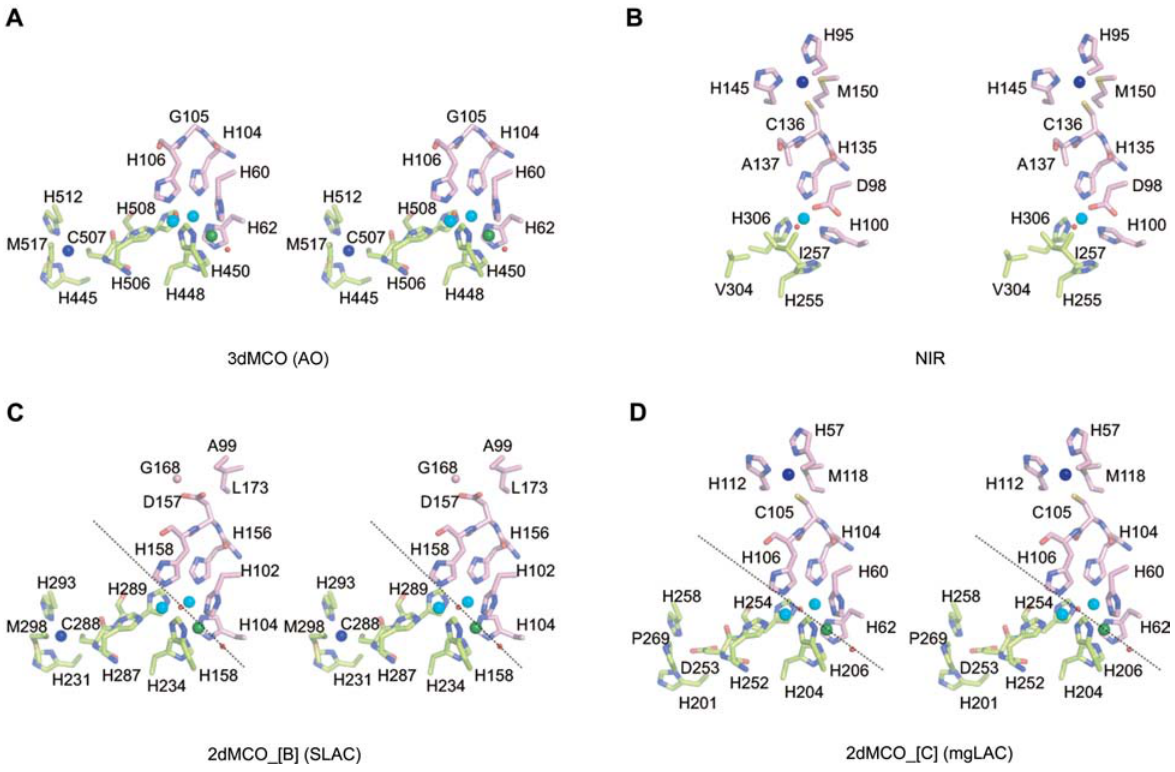
Figure 4 Stereo views of the copper-binding sites of multicopper blue proteins, 3dMCO (AO) (A), NIR (B), 2dMCO_ w B x (SLAC) (C), and 2dMCO_ w C x (mgLAC)